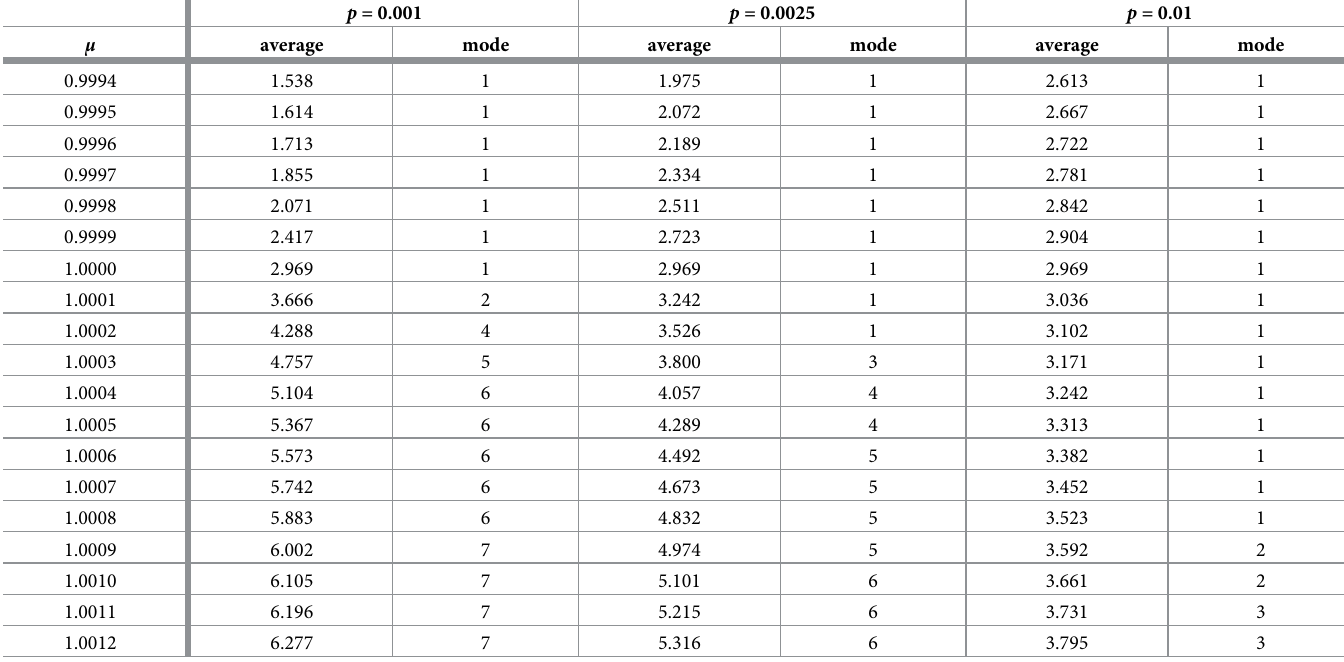
23 human chromosomes (Table 2), for N = 8 and different values of p , as well as the average of these limiting distributions. The average number of chromosome copies in the limit is 3.3591 Table 3. The average and the modal number of chromosome copies in the limiting distribution of A on viable cells, for N = 8 and varying p and μ . p = 0.001 p = 0.0025 p =